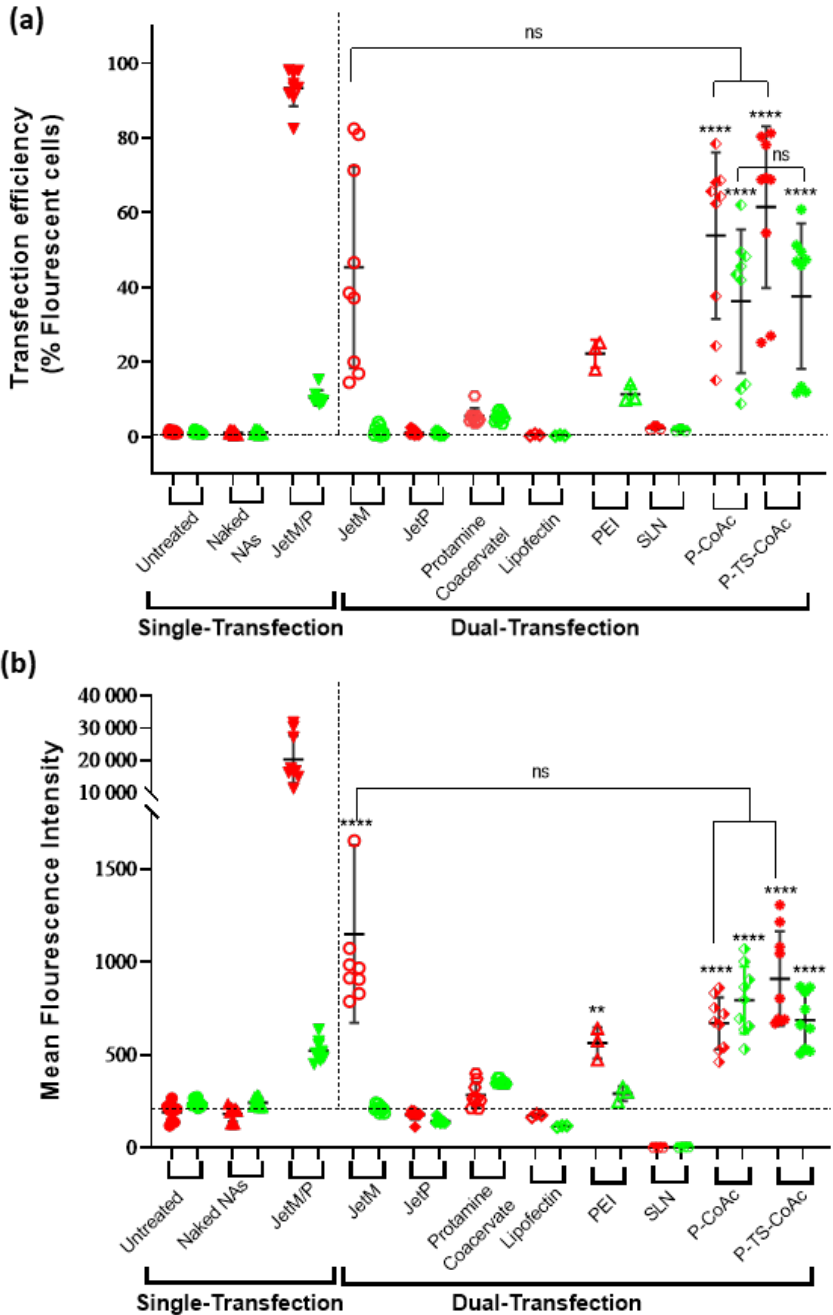
Figure 6. Flow cytometric assessment of ( a ) transfection efficiency and ( b ) mean fluorescence intensity (MFI) of pAmCyan and mCherry loaded on P-CoAc and P-TS-CoAc, compared to single transfection using either JetMessenger for mRNA or JetPrime for pDNA or double transfection using both mRNA and pDNA with either JetMessenger, JetPrime, protamine sulfate ( N = 3, n = 3), Lipofectin, PEI or SLN ( N = 1, n = 3) coacervate in murine dendritic cell line DC2.4; ** p < 0.01, **** p < 0.0001, ns = not significant.